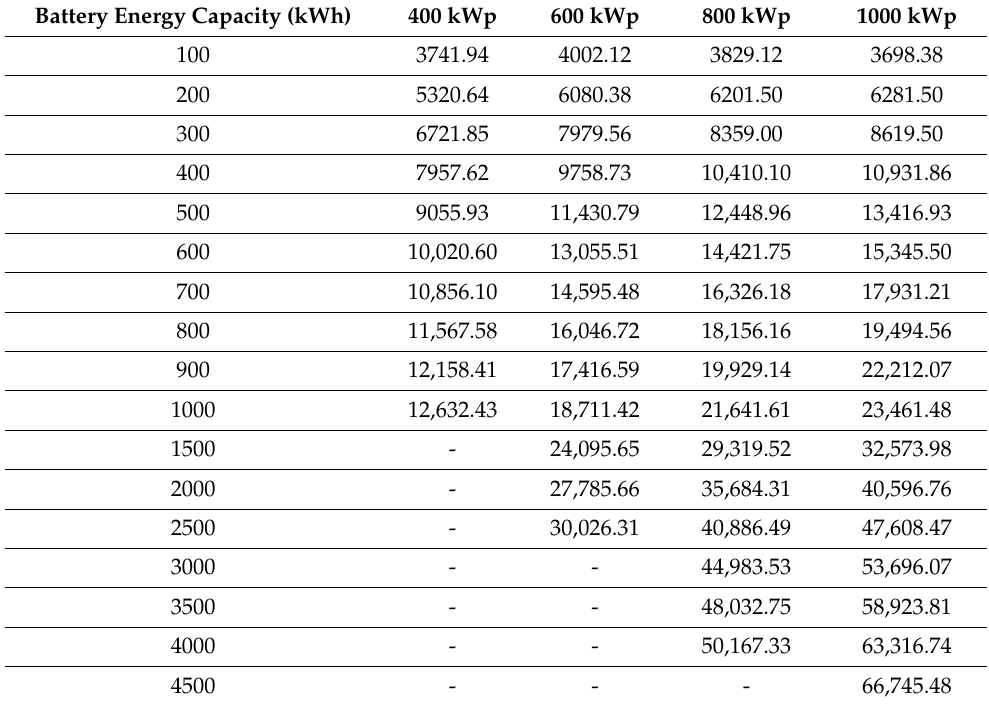
Table 7. Estimated annual oxygen production in kg produced from surplus energy generated by the PV